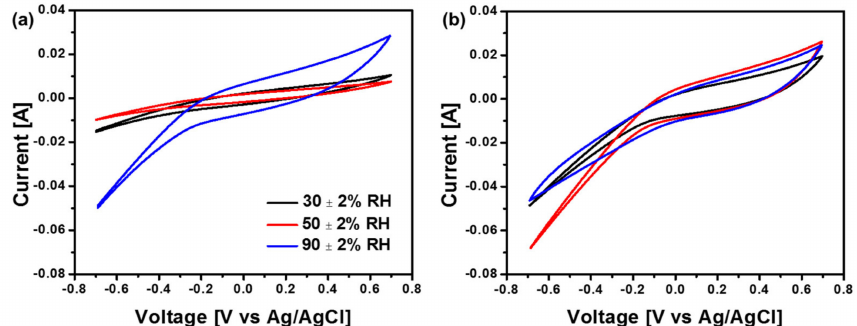
Figure 4. Cyclic voltammogram analysis of air-cathode MFCs with Nafion 117 ( a ) and PP80 ( b ) at di ff erent relative humidity (RH).